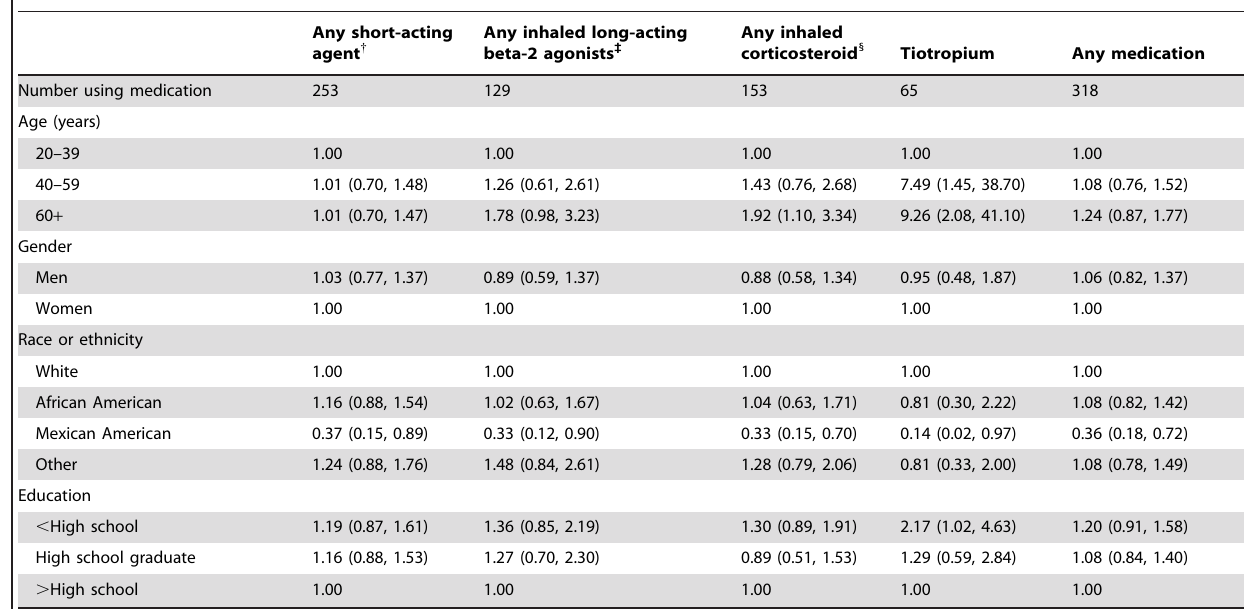
Table 4. Adjusted prevalence ratios* (95% confidence interval) for use of prescription medications used to treat chronic obstructive pulmonary disease among 770 adults aged $ 20 years with self-reported chronic obstructive pulmonary disease, National Health and Nutrition Examination Survey 2005–2010.